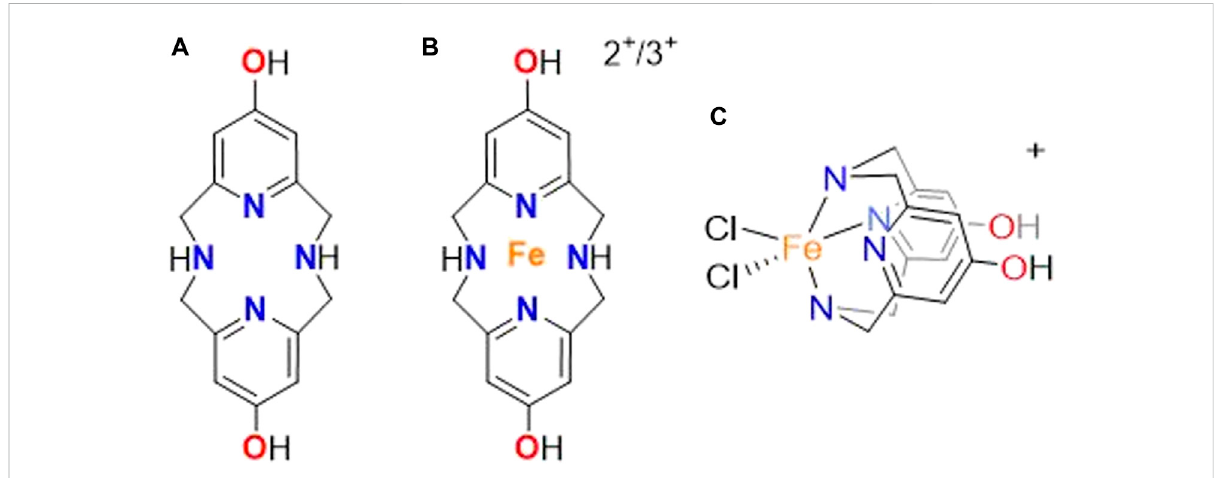
FIGURE 1 Structure of the (A) OH Py 2 N 2 molecule along with the connectivity of the (B) iron (II) and (III) complex and (C) orientation of the iron in the OH Py 2 N 2 ligand based on UV-vis